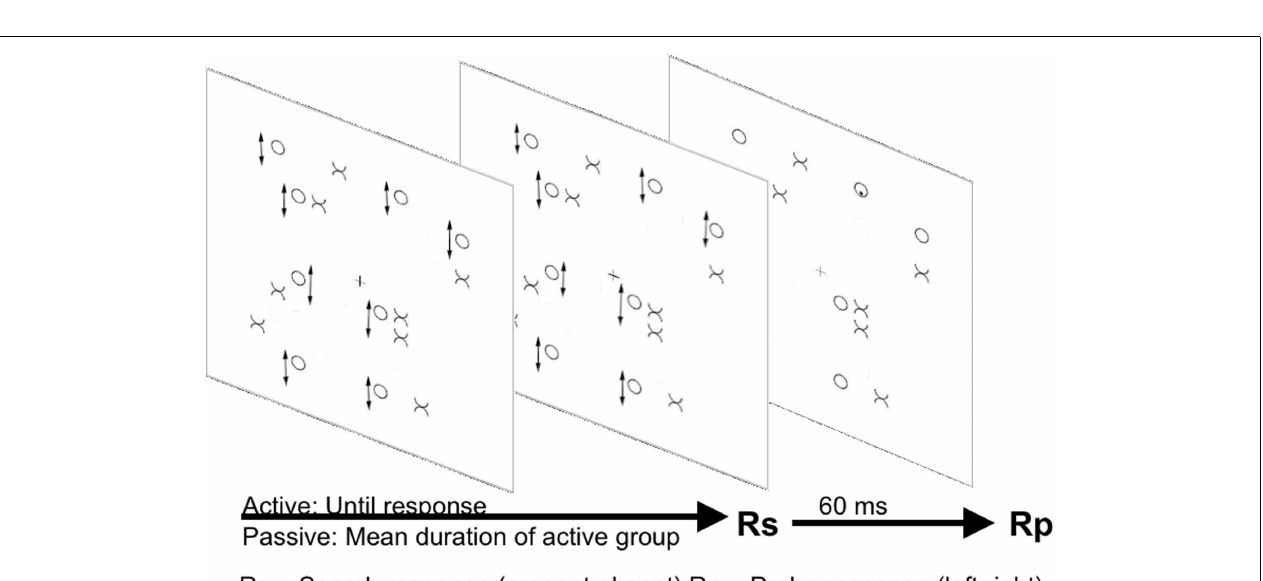
suggestedthatdistractorinhibitionwasthemoreimportantmech- anism. Dent et al. (2012) used the probe-dot task in an attempt to resolve this issue. Dent et al. (2012) showed that, when par- ticipants searched for a moving X amongst moving O and static X distractors, there were costs for probes presented on static X distractors consistent with inhibition of the location of the